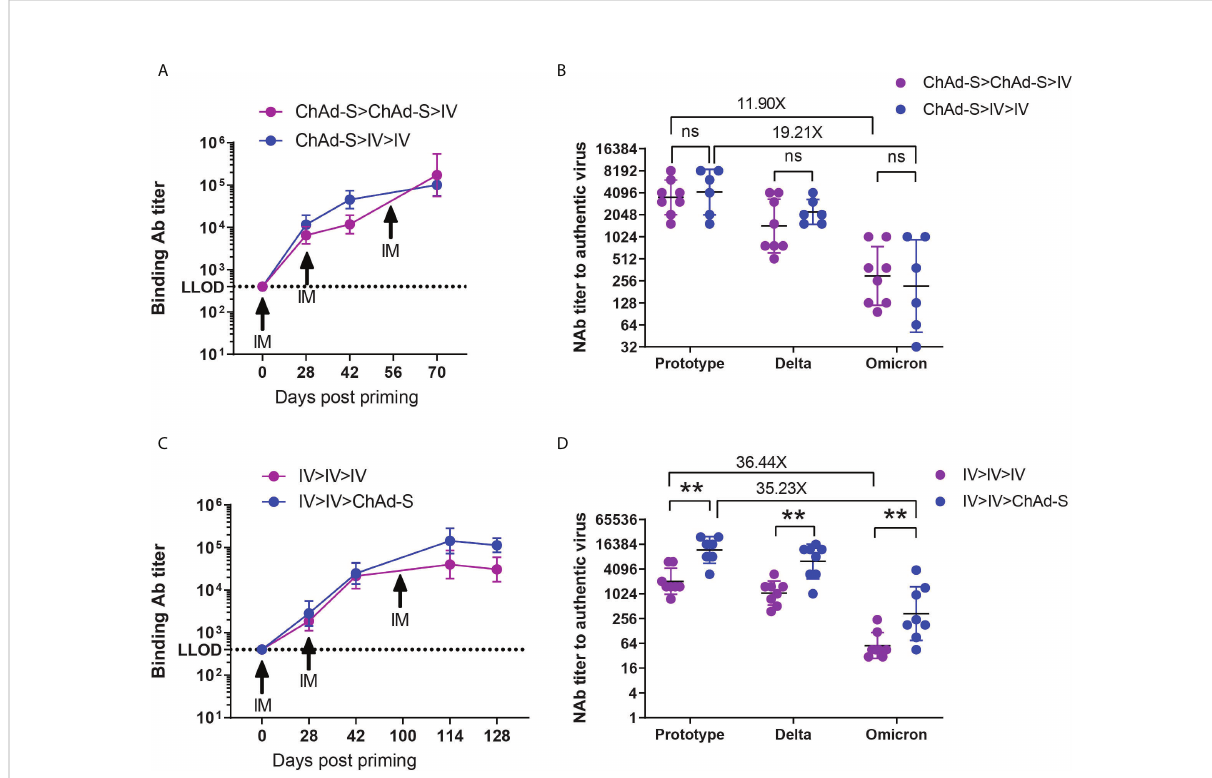
FIGURE 6 The humoral immune responses induced by additional heterologous or homologous booster in mice. (A, B) Mice immunized with 2×ChAd-S and ChAd-S>IV on day 0 and 28 were further boosted by ChAd-S on day 56. Serum spike speci fi c IgG titers were measured by ELISA on day 0, 28, 42 and 70 (A) , and NAb titers against Delta and Omicron were measured on day 70 and expressed as 50% inhibitory dilution (EC50) of serum (B) . (C, D) . Mice immunized with 2×IV on day 0 and 28 were further boosted by IV or ChAd-S on day 100. Serum spike speci fi c IgG titers were measured by ELISA on day 0, 28, 42, 114 and 128 (C) , and NAb titers against Delta and Omicron were measured on day 114 and expressed as 50% inhibitory dilution (EC50) of serum (D) . N=9 per group. Student ’ s t test was performed for b and d. Bars represent the geomean ± geometric SD, ns: p>0.05,